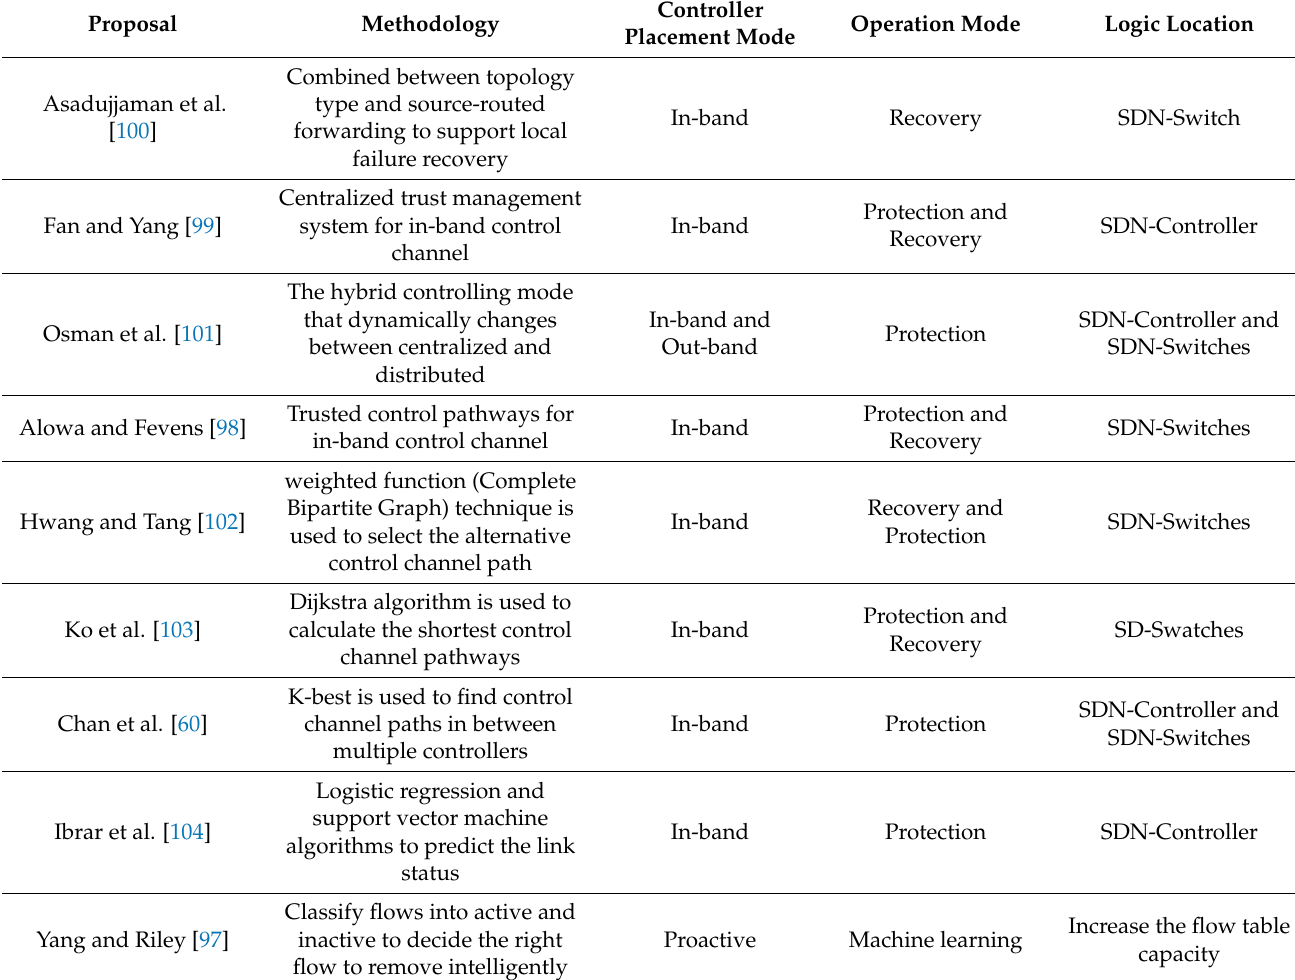
Table 6. Comparison of control channel schemes to improve OpenFlow